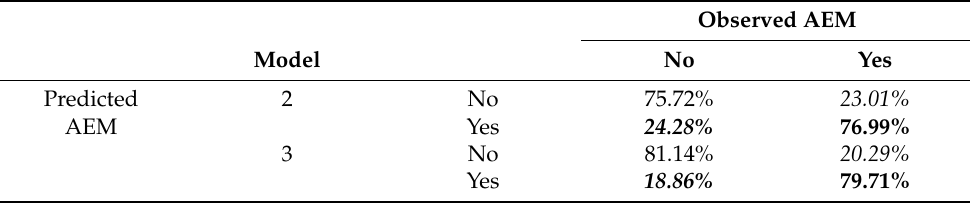
Table 3. Coverage and leakage rates for Models 2 and 3. Bold values refer to coverage rates, bold italicized values to over-coverage rates, and italicized values to under-coverage